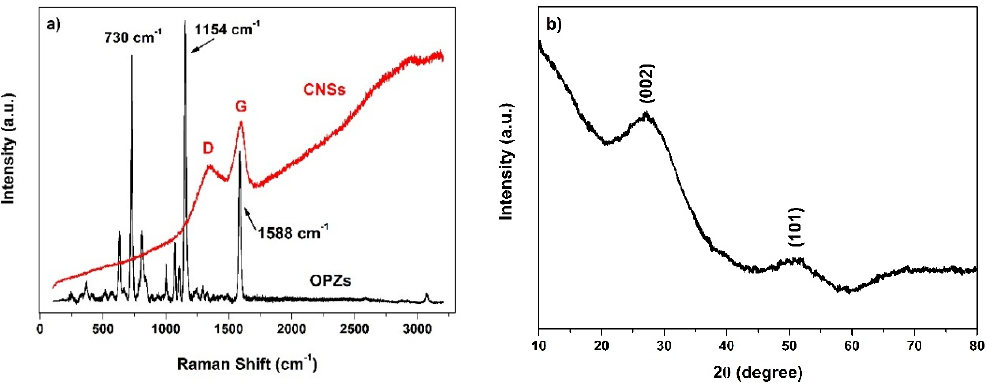
Figure 2. ( a ) Raman spectra of the OPZ and the CNSs; and ( b ) XRD pattern of the CNSs.